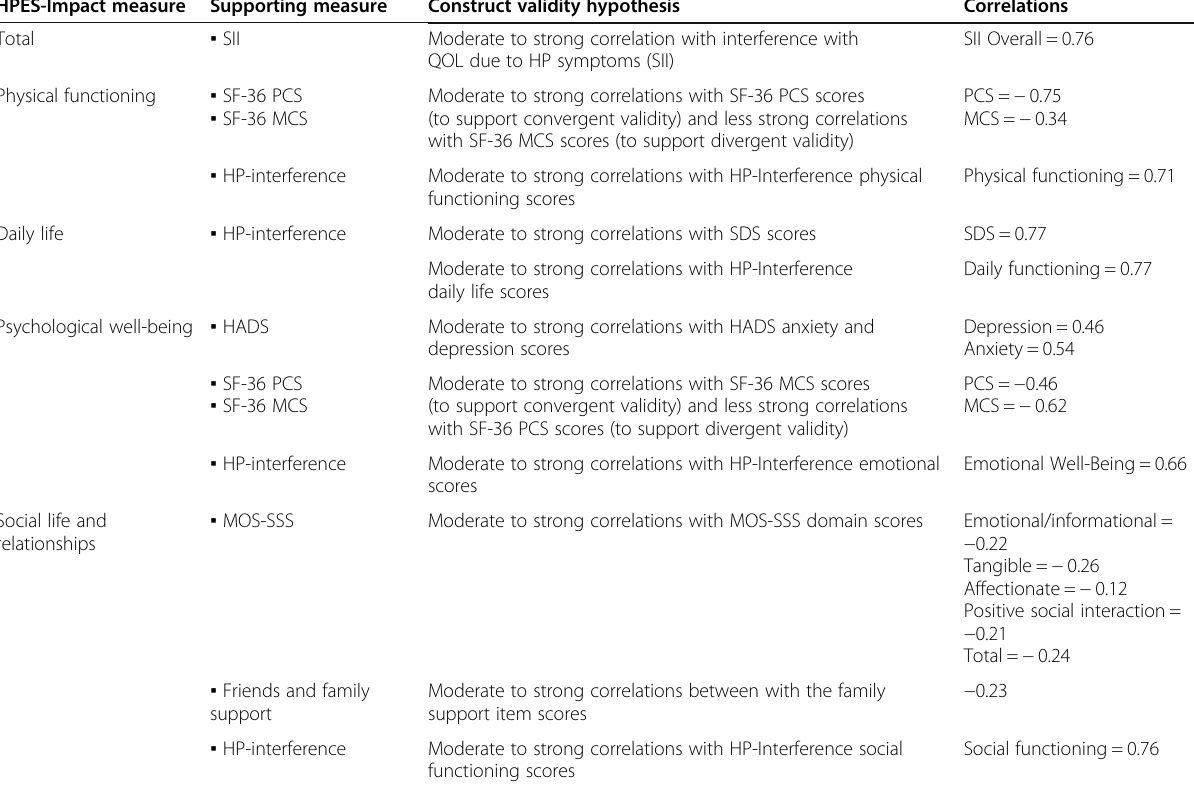
Table 8 Observational study construct validity hypotheses for HPES-Impact at